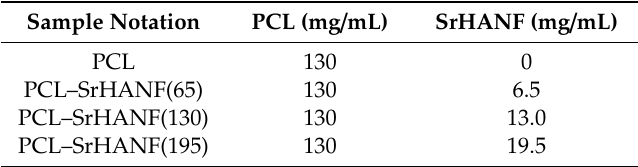
Table 1. Sample notations and amounts of poly( ε -caprolactone) (PCL) and